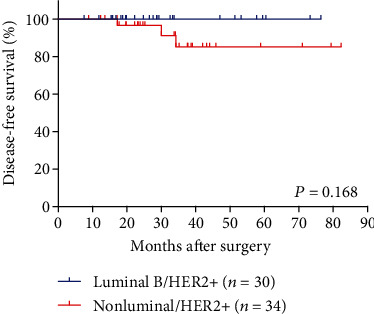
DFS curves of luminal B/HER2+ and nonluminal B/HER2+ patients in non-pCR patients administered with trastuzumab.